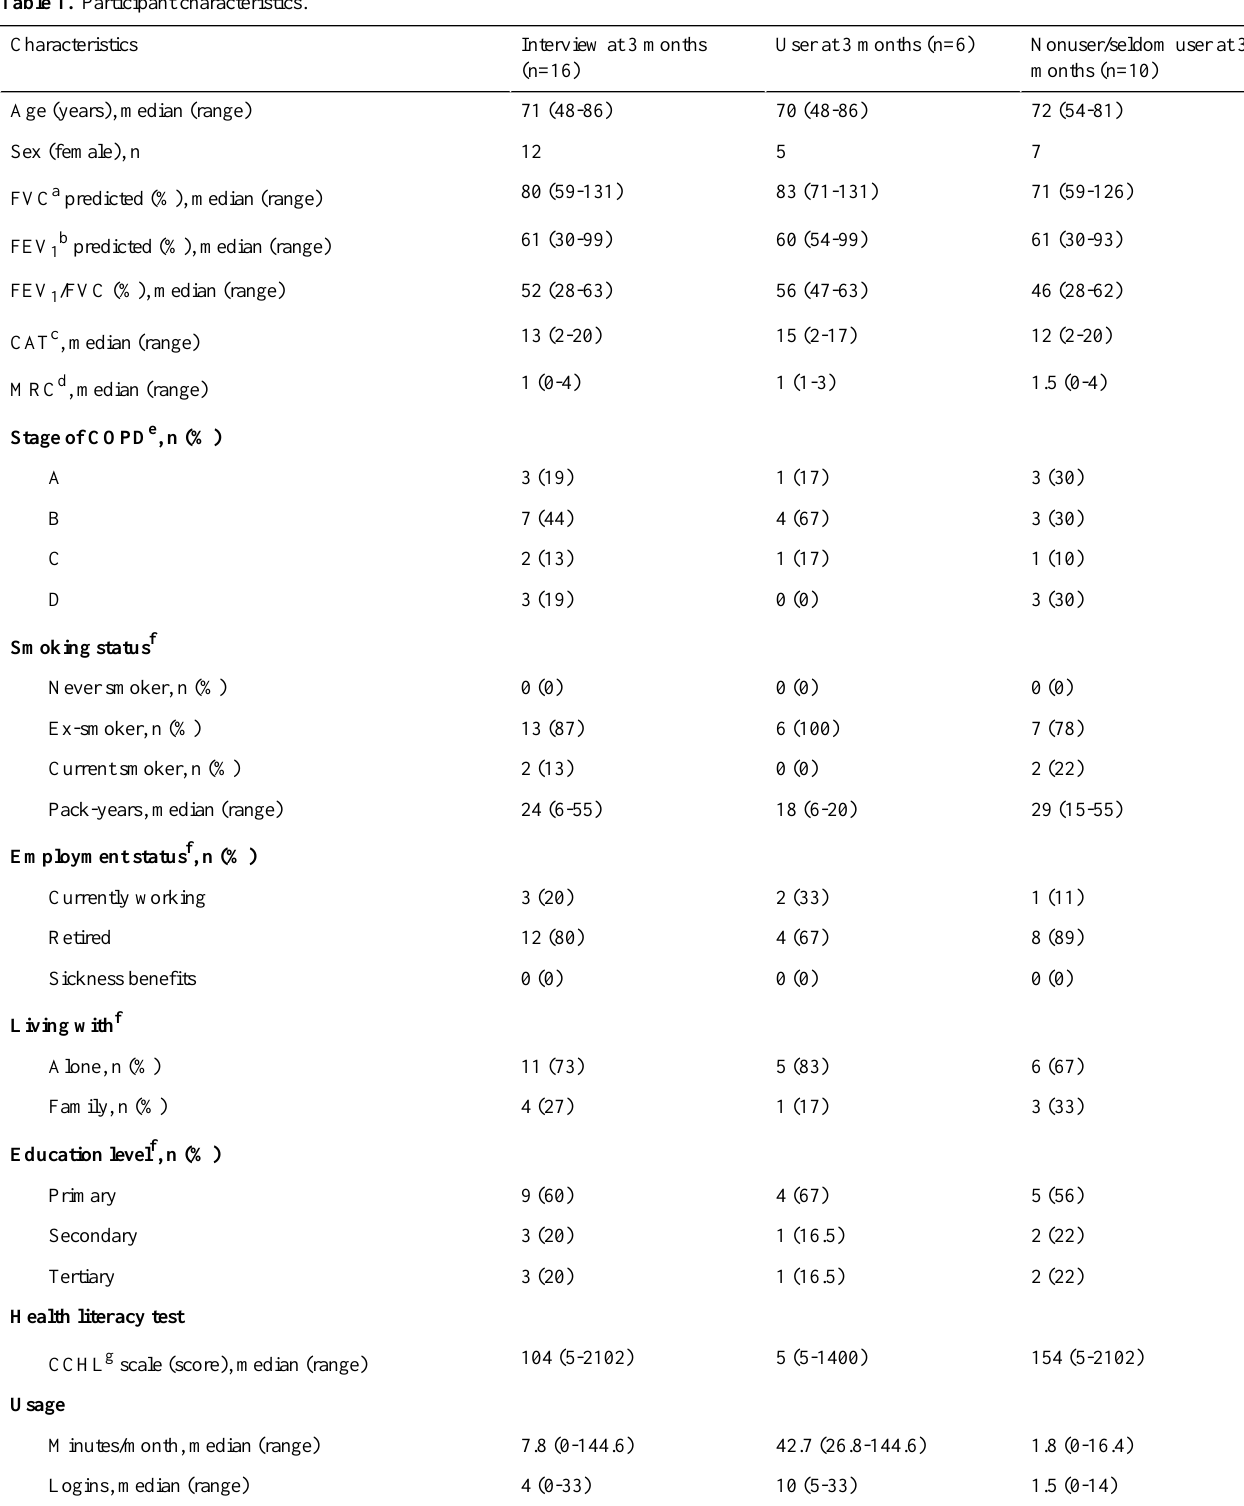
Table 1. Participant characteristics.